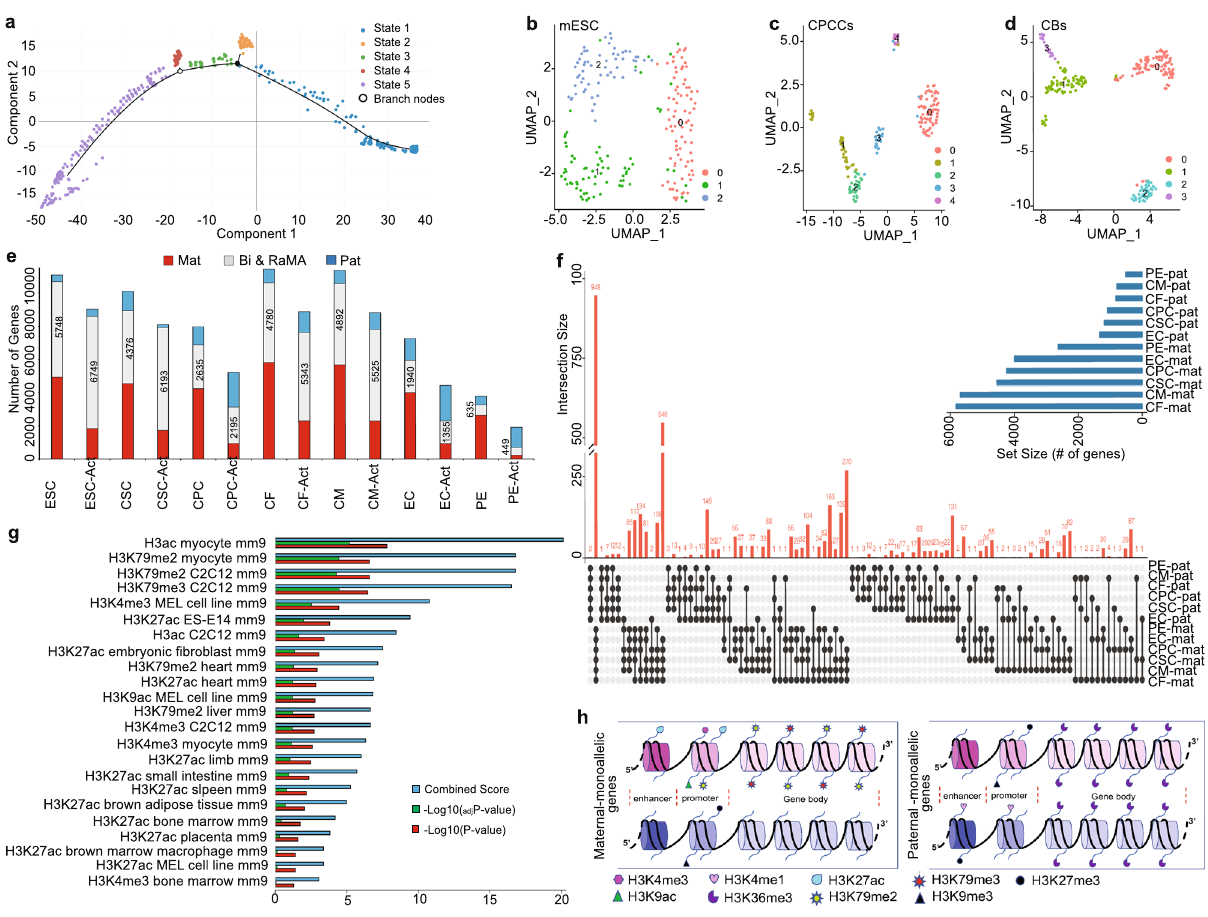
Fig. 2 | Allele expression in cardiac cell types and allele-speci fi c differential epigeneticregulationofmonoallelicgenes.a Pseudotimetrajectoryanalysisfor mESCs, CPCCs and CBs scRNA-Seq data. Trajectory shows the linear-lineage cor- relation of three experimental points. State 1: mainly mESCs, State 2, 3, and 4: mainlyCPCCs,State5:mainlyCBs.Nodesofthetrajectoryindicatetheterminating points between the experimental points. b – d Uniform Manifold Approximation andProjection(UMAP)basedsystematiccellclusteranalysisformESC,CPCCs,and CBs scRNA-Seq data points. UMAP plots show three clusters for mESC, fi ve for CPCCs (Cluster 0: CSC, Cluster 2: CPC) and four for CBs (Cluster 0: CF, Cluster 1: CM, Cluster 2: EC, Cluster3: PE). e Number of bi-allelic and DeMA genes expressed in seven cell types. For each cell type, the number of bi-allelic and DeMA genes expressed areshown fortwotranscriptcategories: maturetranscripts and nascent transcripts. f Intersects of all maternal and paternal monoallelic genes in cardiac lineage cell types. Signi fi cantly higher number of mat-mono genes are shared betweenallcardiaccelltypesthanpat-monogenes.Alleleswitchinglesscommonly